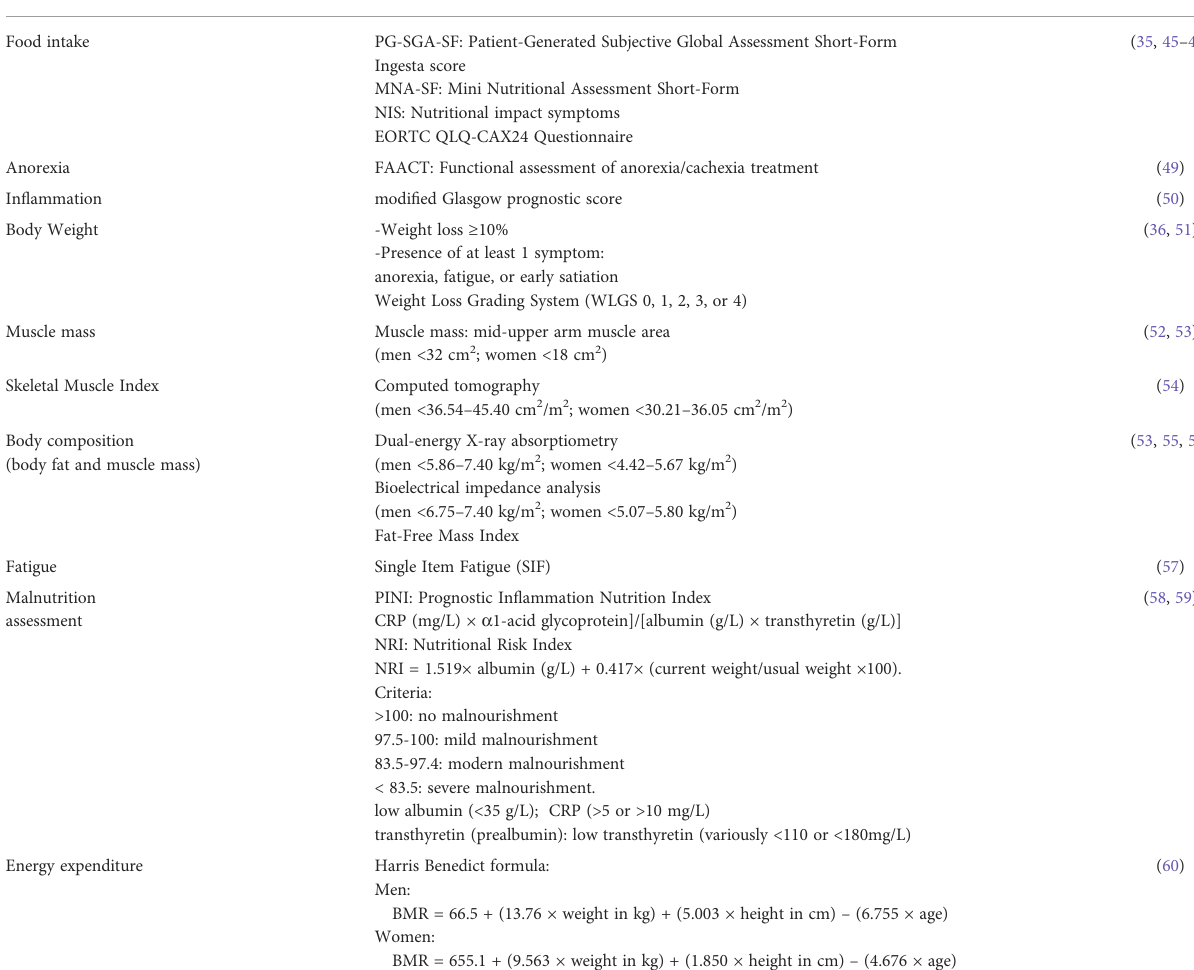
TABLE 2 Cachexia